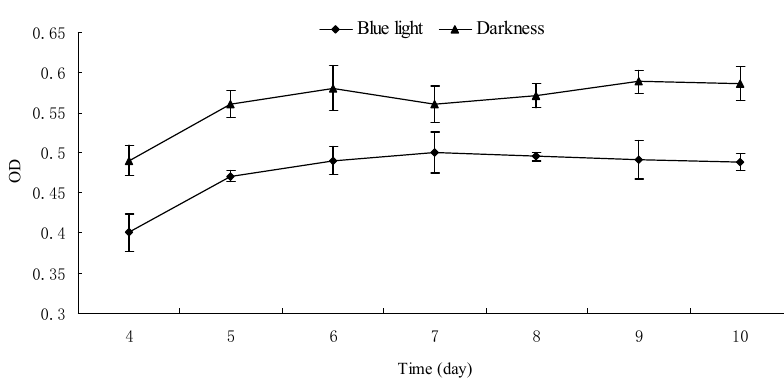
Figure 4. Effect of blue light on glucosamine content of Monascus mycelium wall. Monascus mycelium wall is composed of chitin, whose content is determined by the measurement of glucosamine released by the acid hydrolysis of chitin. The amount of glucosamine in Monascus mycelium wall cultured under blue light and darkness was determined by the absorbance at 530 nm. Experimental conditions are described in Section 3.9.